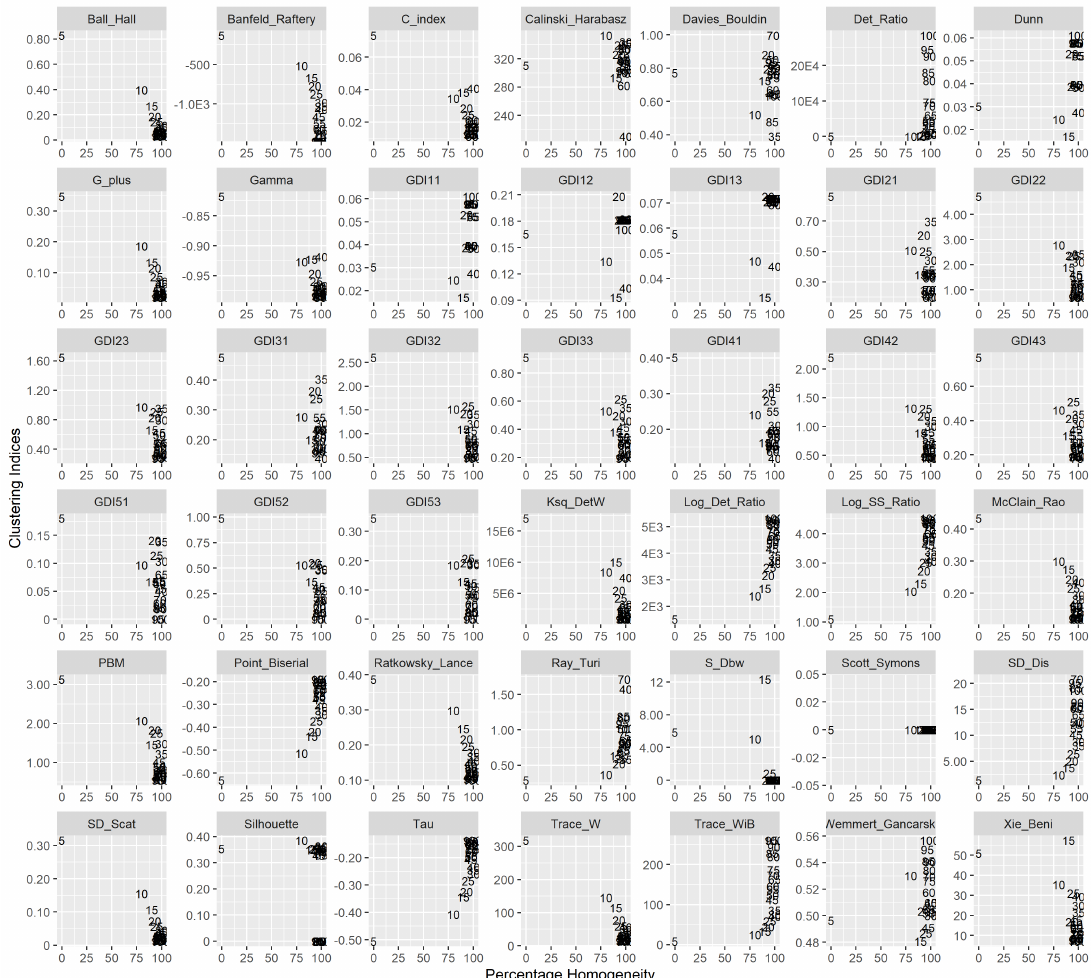
Figure 10. Performance of cluster validity indices in GL-SL region—Spring season. The numbers indicate the percentage homogeneity for the number of clusters in the x-axis and index value on the y-axis. The scientific notation ‘E’ used in labels of y-axis represent ‘10 to the power